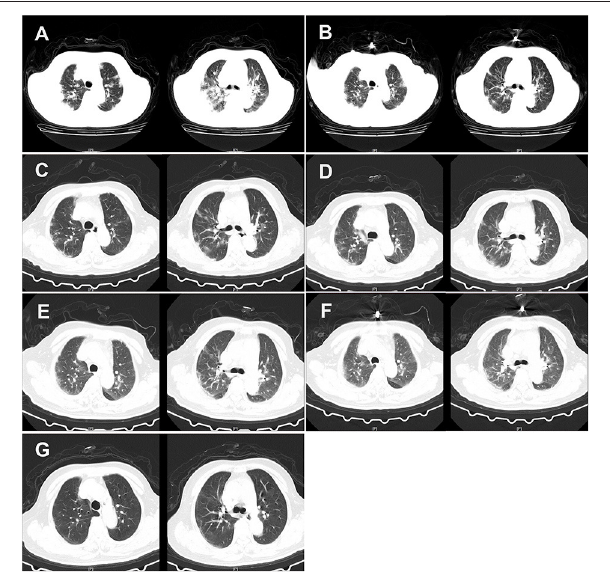
FIGURE 1 | CT of the chest of the patient. (A) CT of the chest was obtained on February 12, 2020 (hospital day 2, illness day 6). The major morphogenesis of her bilateral lungs took on increased bronchovascular shadows and multiple patchy and maculas shadows, with cord-like ground-glass opacity (GGO) in the middle and lower regions of the lung. CT scan of the chest also showed increased lung markings. The texture of the trachea and blood vessels in both the lungs became thicker. (B) CT of the chest was obtained on February 16, 2020 (hospital day 6, illness day 10). The patchy lesions and maculas in both the lungs were partially absorbed. Increased lung markings were observed in the bilateral lungs. (C) CT of the chest was obtained on February 20, 2020 (hospital day 10, illness day 14). Decreased density of the patchy lesions in both the lungs was observed. The texture of the trachea and blood vessels in both the lungs became thicker. (D) CT of the chest was obtained on February 24, 2020 (hospital day 14, illness day 18). The pulmonary lesions remained unchanged. (E) CT of the chest was obtained on February 28, 2020 (hospital day 18, illness day 22). There was no obvious change in the patchy lesions in both the lungs. GGO was slightly increased. (F) CT of the chest was obtained on March 3, 2020 (hospital day 22, illness day 26). The major lesions of the bilateral lungs were not absorbed. (G) CT of the chest was obtained on March 10, 2020 (hospital day 29, illness day 33). The multiple patchy and maculas shadows of the bilateral lungs were further absorbed and the bronchovascular shadows were